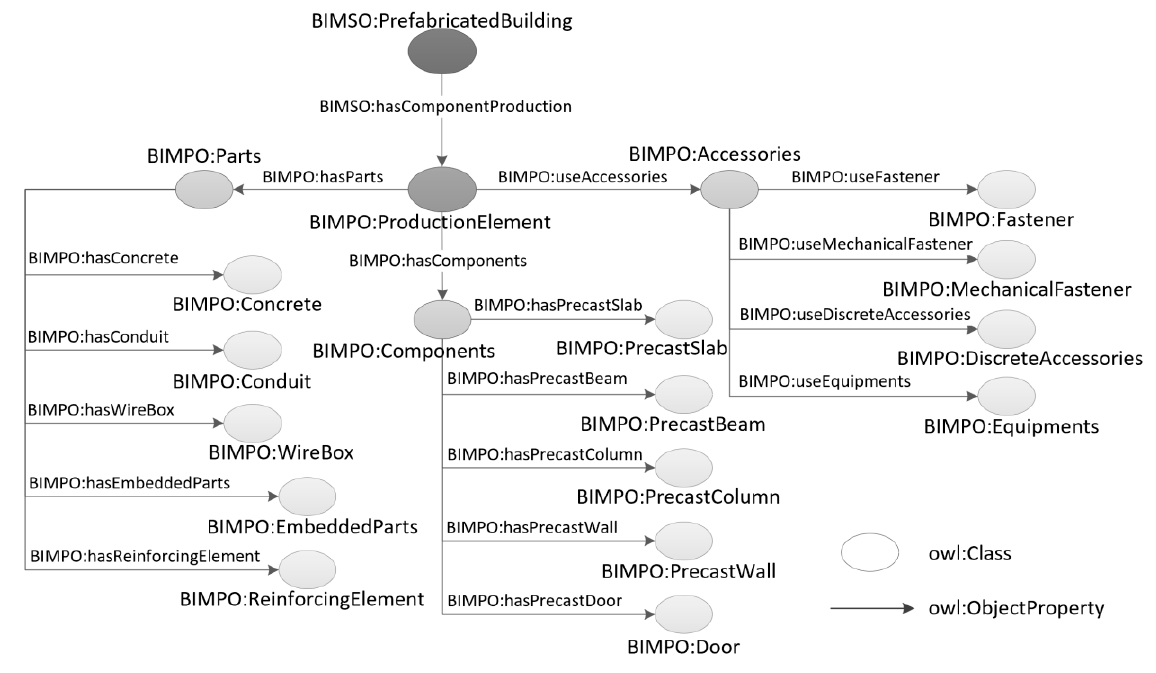
Figure 10. Conceptual diagram of BIM production ontology.